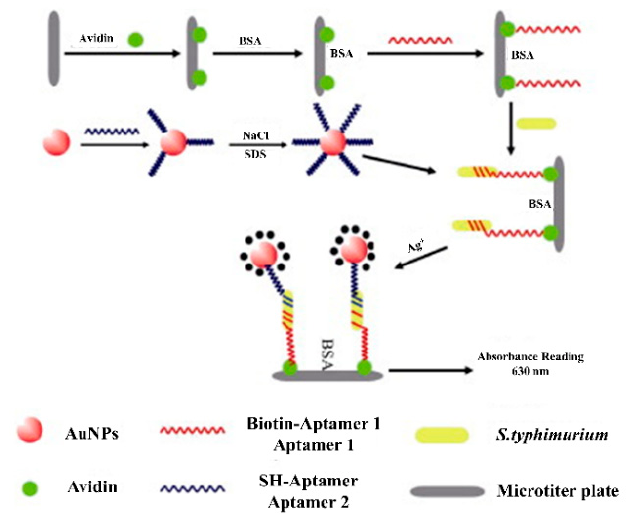
Figure 2. Detection of Salmonella typhimurium via attachment of avidin and AuNPs for recognition of biotinylated aptamer 1 and SH-aptamer 2, respectively. Adapted with permission from Ref. [22]. Copyright 2014, Elsevier.